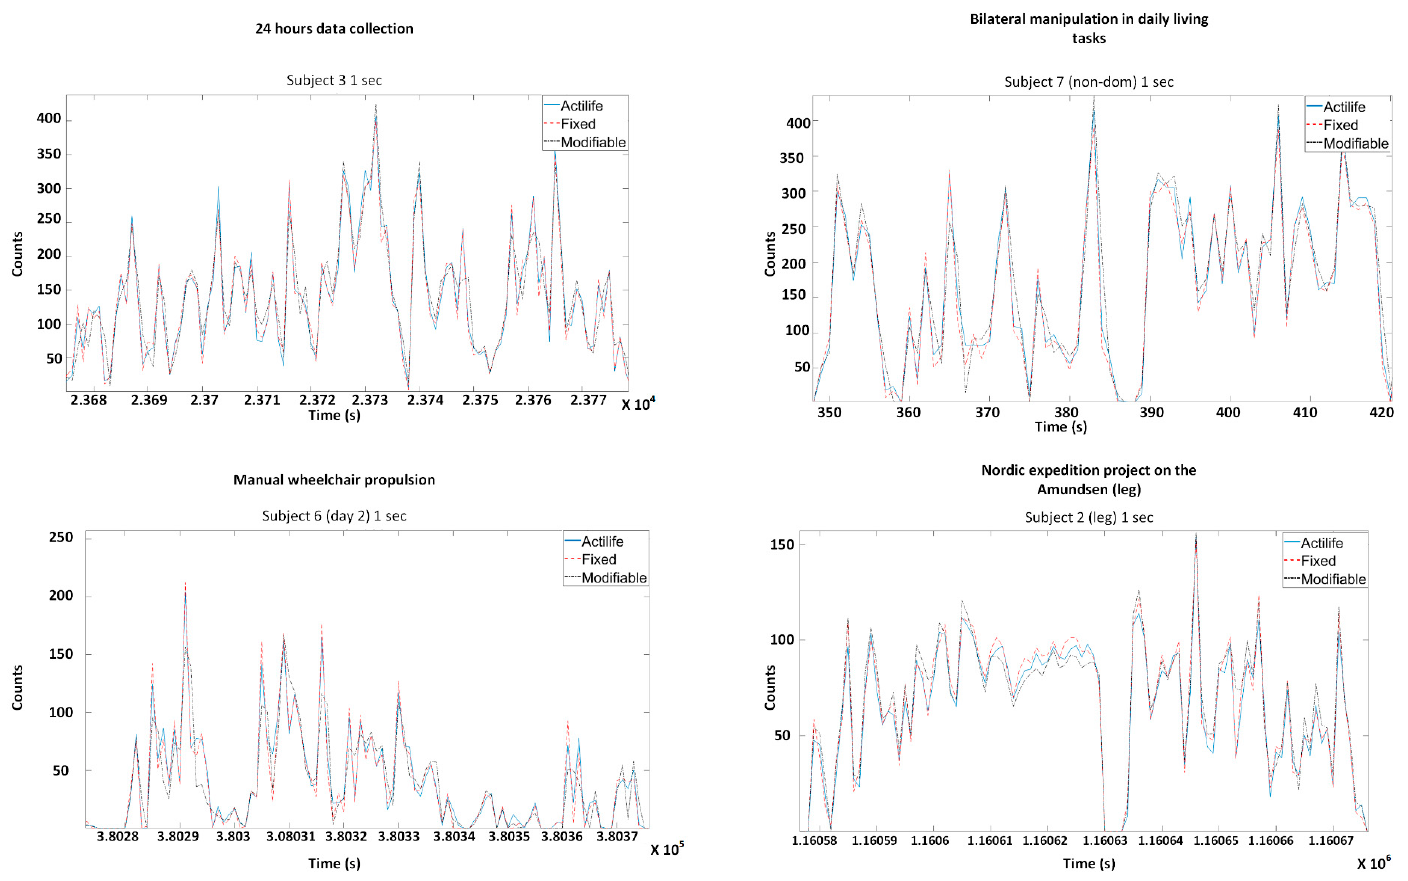
Figure 4. Representative subjects for each project comparing the commercial activity count to the fixed and modifiable algorithm.